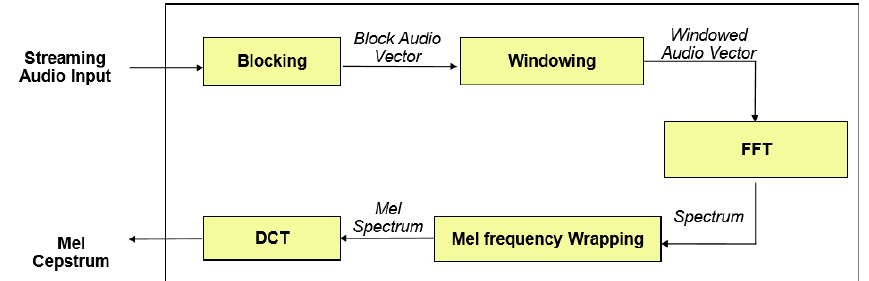
Figure 2. Steps involved in MFCC